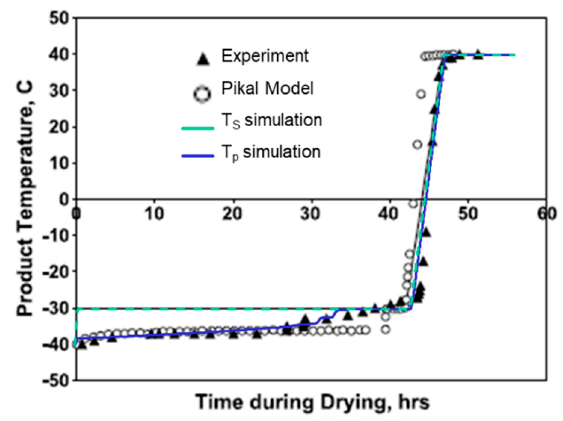
Figure 12. Comparison of measured data for product temperature and simulated temperature. Taken from [59].